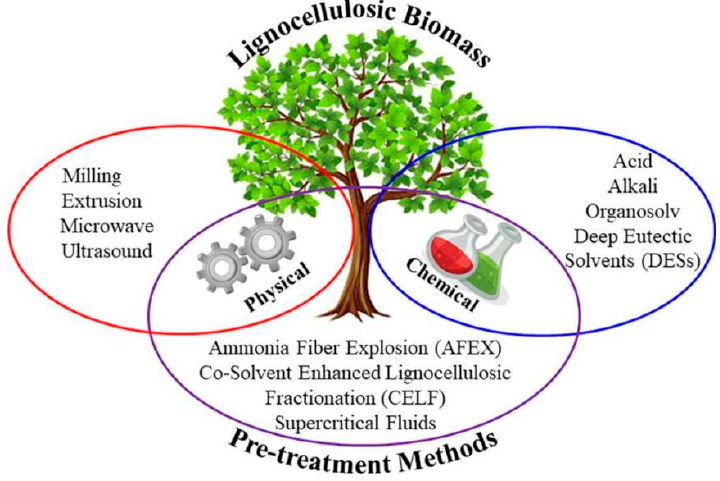
Figure 2. Various physical and chemical pretreatment technologies [18].